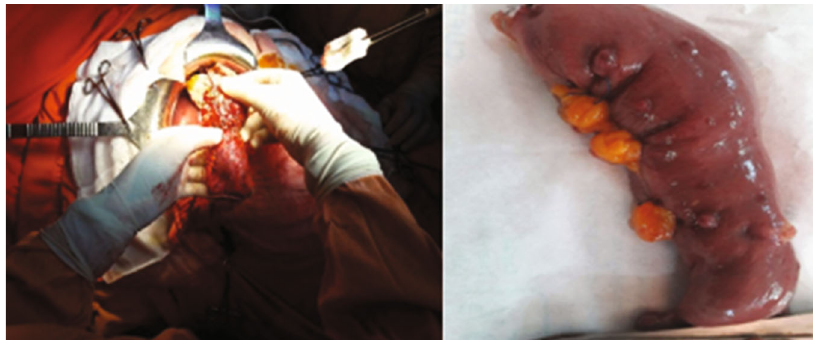
Figure 5: A tumor located 7cm from the major axis, located at D1 with exophytic lesions, of centimeter size, located at the surface of the small bowel, resembling fi